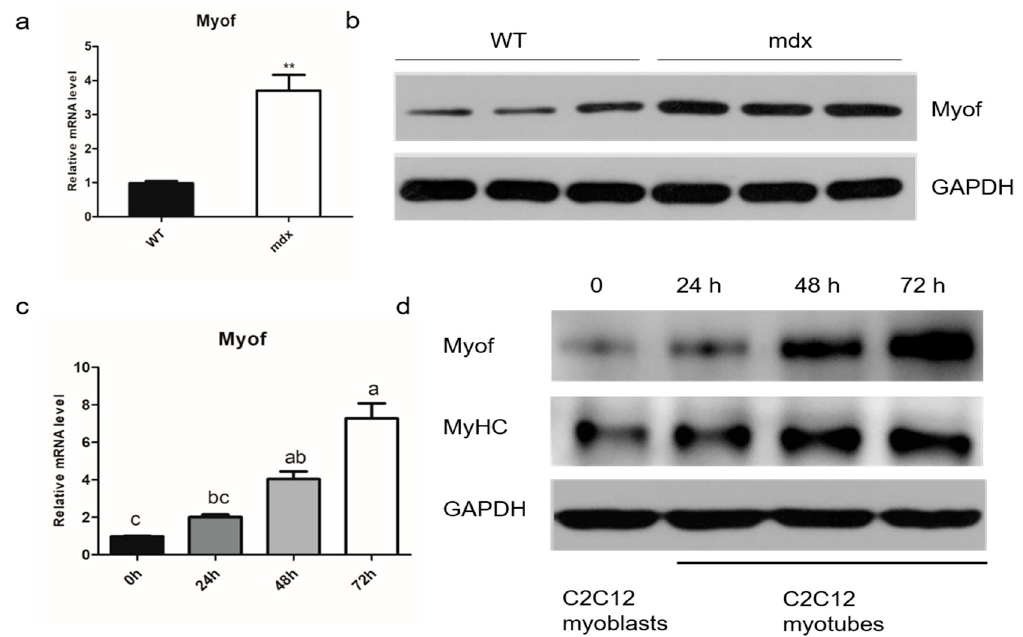
Figure 1. MyoF participates in adult skeletal muscle regeneration and myoblast differentiation. ( a ) Quantitative real-time PCR (qRT-PCR) analysis of MyoF expression in wild-type (WT) and mdx mice (aged 9 months); n = 3 per group. ( b ) Western blot analysis of MyoF protein levels in WT and mdx mice (aged 9 months); n = 3 per group. ( c ) qRT-PCR analysis of MyoF mRNA expression in C2C12 cells during differentiation. Bars not sharing the same letter labels are significantly different ( p < 0.05; n = 3 independent cell cultures). ( d ) Western blot analysis of MyoF and MyHC protein levels during differentiation; GAPDH was used as loading control. Data represent means ± SEM ( n = 3 independent cell cultures). * p < 0.05; ** p < 0.01.